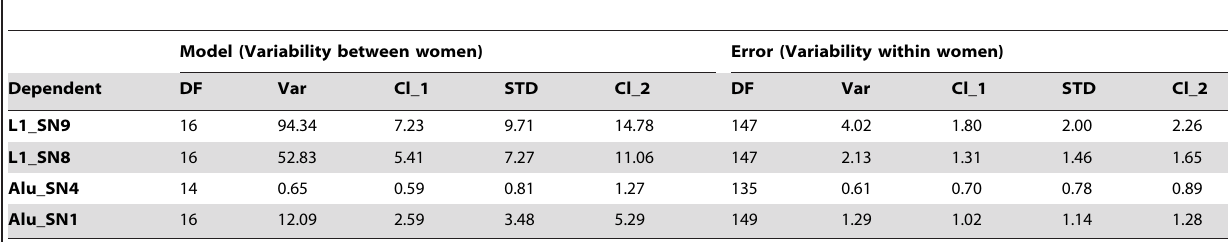
Upper and lower confidence limits are also shown. (DF: degree of freedom, Var: calculated variability parameter, Cl_1 and 2: Confidence limits of the standard deviation, STD: standard deviation).